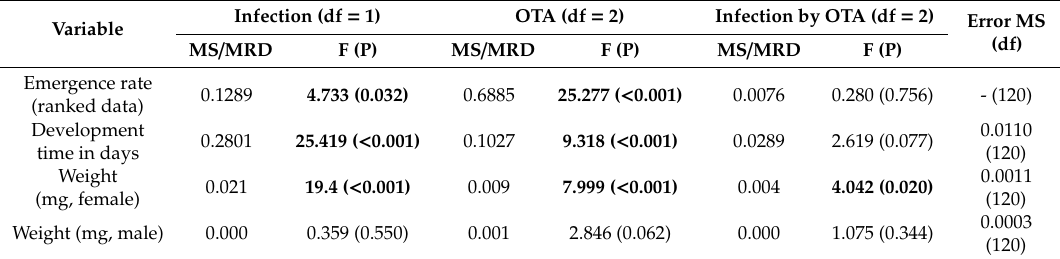
Figure 3. Violin plots for ( a ) emergence rate, ( b ) development time, ( c ) female weight, and ( d ) male weight of w Au-infected and uninfected (wt) larvae reared on three medium conditions (no OTA (Ochratoxin), 0.05 ng / mL OTA, and 0.5 ng / mL OTA in medium). Medians are indicated by central points, and the interquartile range by the solid bar, while the dotted line indicates the 95% confidence interval. Table 4. ANOVAs (MS = mean square or MRD = mean square for emergence based on ranked data, F ratio, probability) for emergence rate, adult weight, and preimaginal development when flies were reared on medium with di ff erent OTA (Ochratoxin) levels. Significant results ( p < 0.05) are indicated in